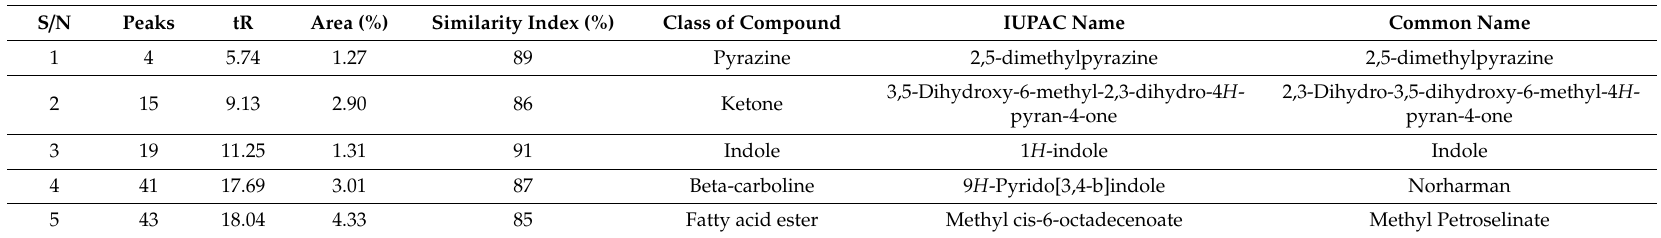
Table 1. Compounds present in the gas chromatography-mass spectrometry (GC-MS) analysis of the unfermented aqueous extract of C. albidum .